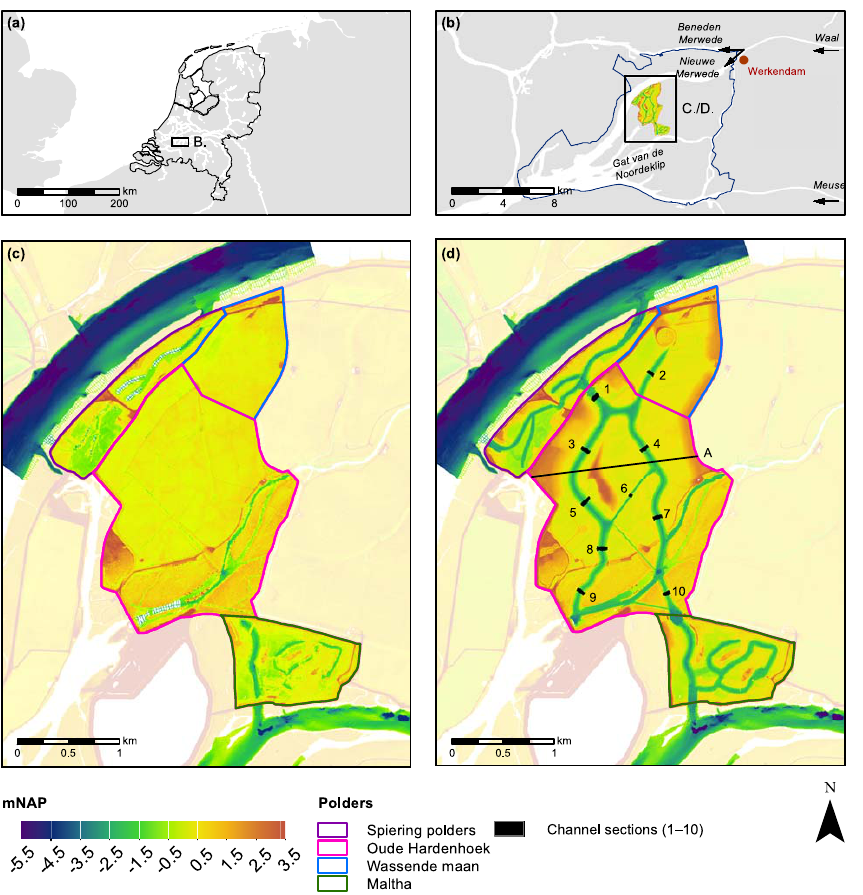
Figure 1. The study area of the Kleine Noordwaard, which is located within the Biesbosch tidal freshwater wetland, in the lower Rhine– Meuse delta in the southwest of the Netherlands (a, b) . Elevation is shown in meters, with respect to the Dutch Ordnance Datum (NAP) for the period before (c) and after depoldering (d)